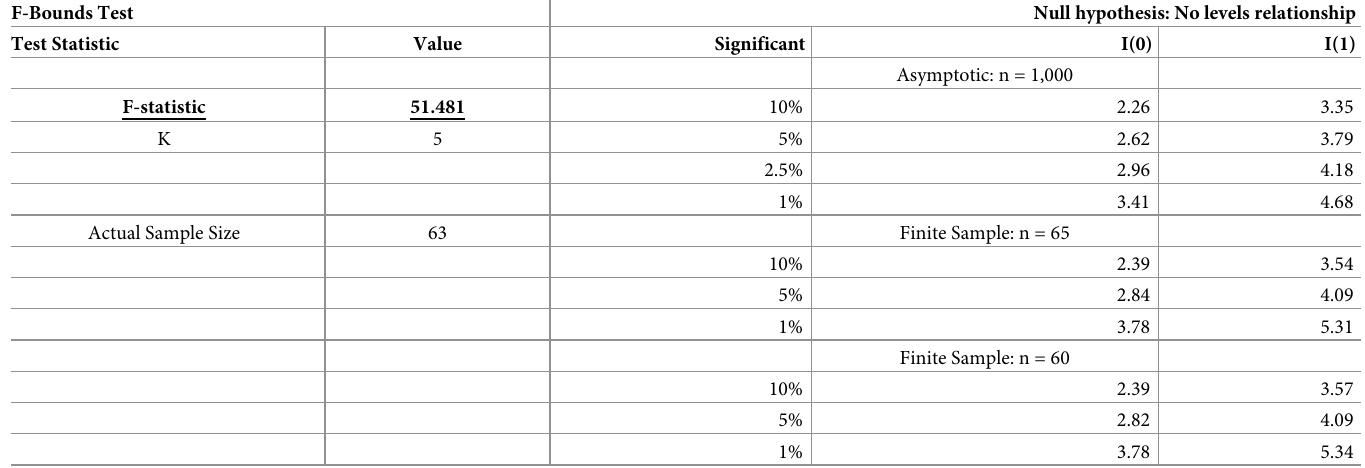
Table 4. Bounds test for